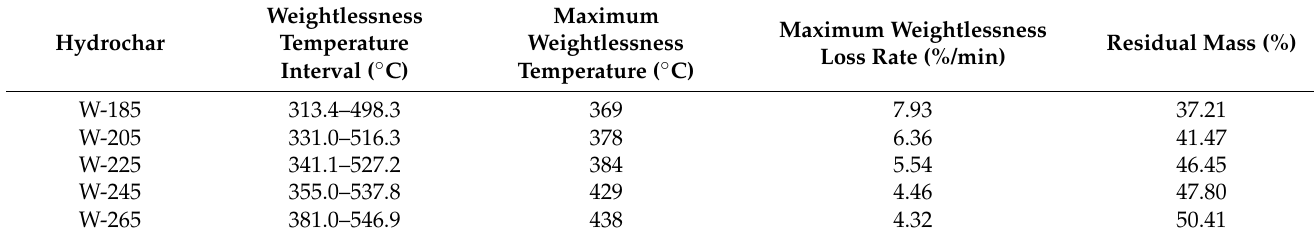
Figure 8. Derivative thermogravimetric (DTG) curves of hydrochar produced at increasing HTC temperatures (185–265 °C) when the heating rate is 20 K/min. Table 2. Pyrolysis characteristic parameters of water carbon at different HTC temperatures.